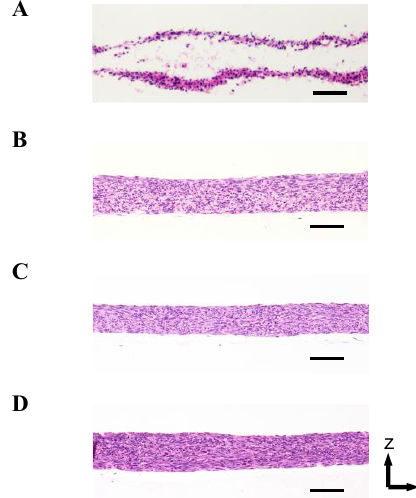
Figure 2. Illustration of the culture system. Overview of the whole perfusion system ( A ). Schematic image of culture device with the collagen scaffold ( B ).